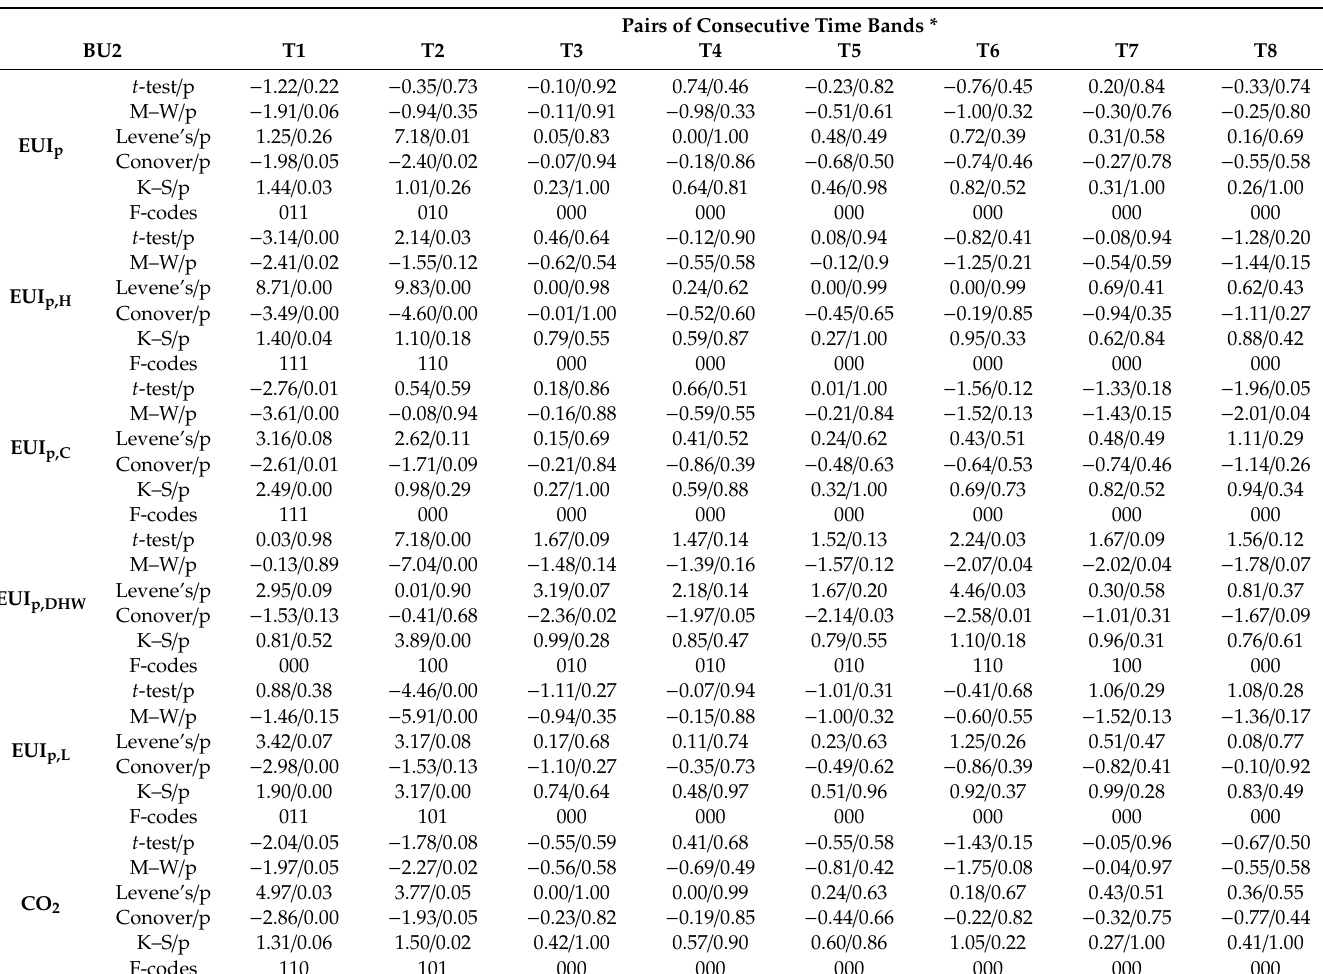
Table 8. Results of the applied statistical tests and failure coding (F-codes) for the various energy use intensities and emissions for BU2–hotel (summer), across the eight pairs of time